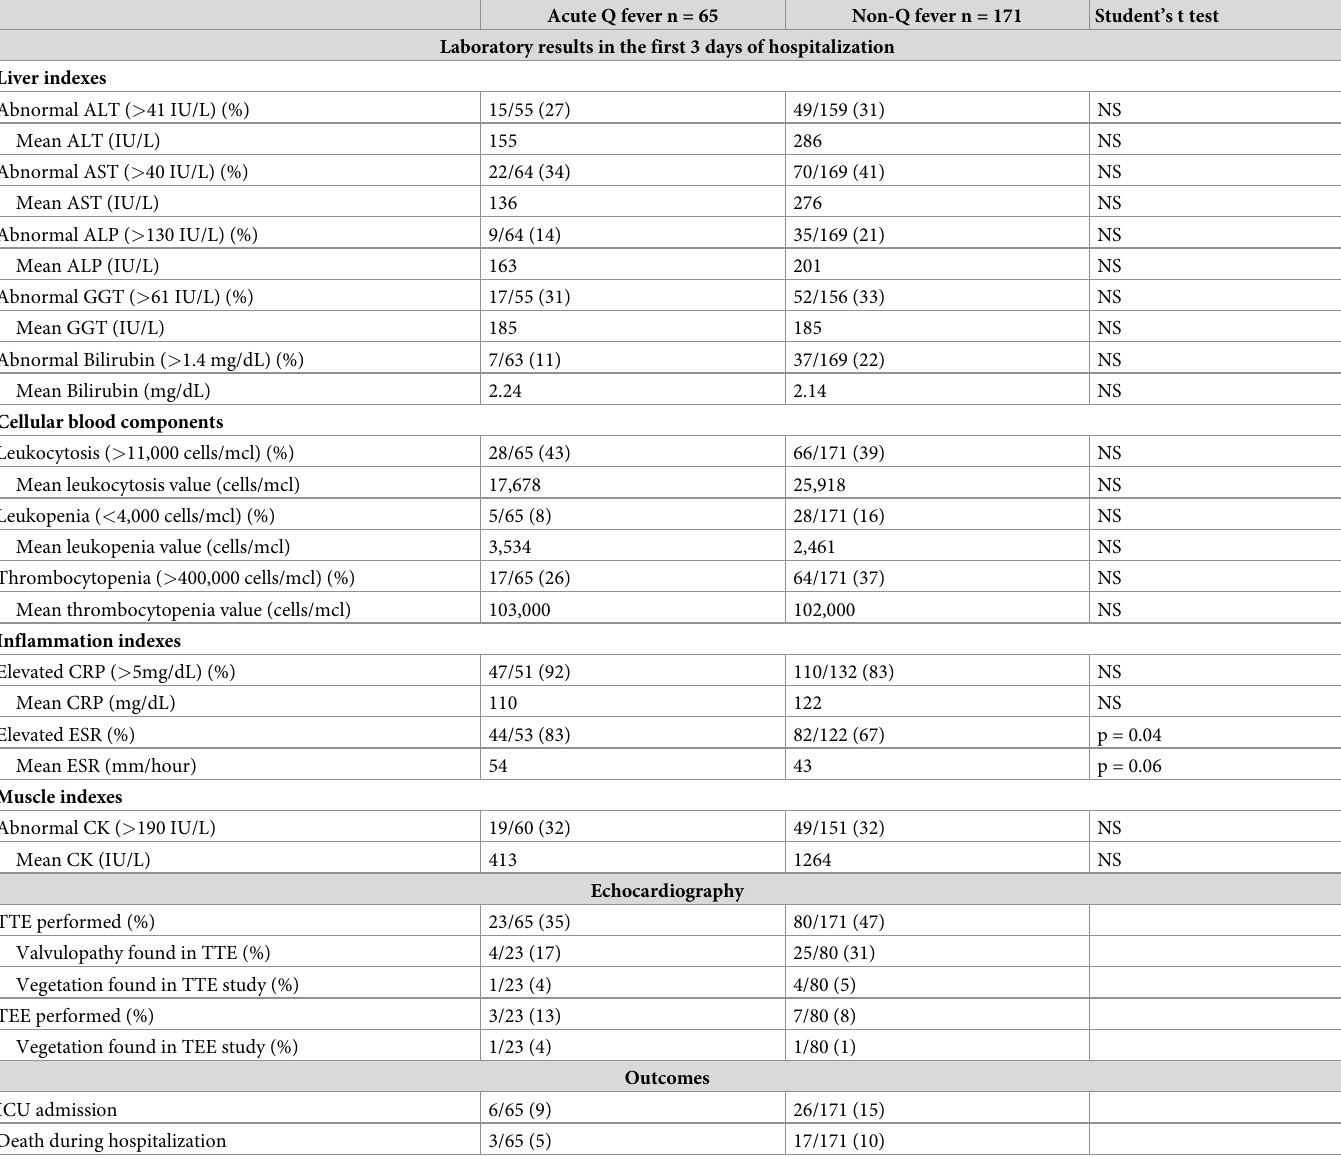
Table 2. Laboratory, imaging, and outcomes of acute Q fever cases as compared with non-Q fever